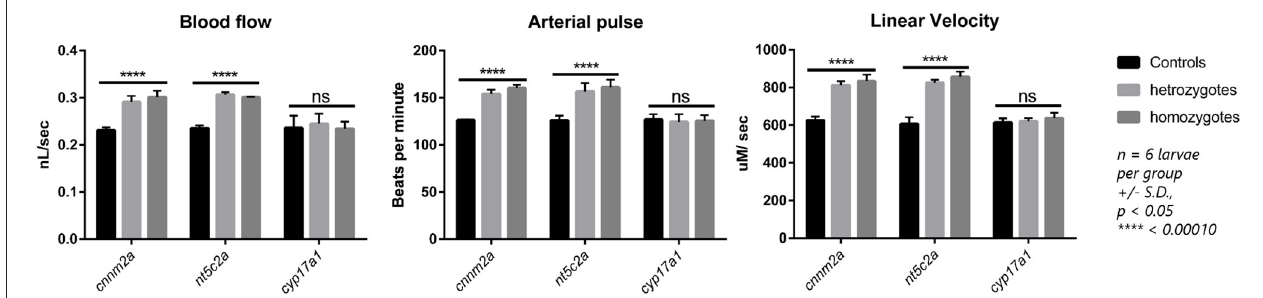
FIGURE 5 | Blood flow parameters measured from heterozygote and homozygote cnnm2a, nt5c2a, and cyp17a1 zebrafish mutants and compared against ab-wildtypes as control. Blood flow (nL/sec), arterial pulse (beats per minute) and linear velocity ( µ M/sec) were measured from n = 6 larvae per group and presented here as mean ± standard deviation and significance was set at p < 0.05.